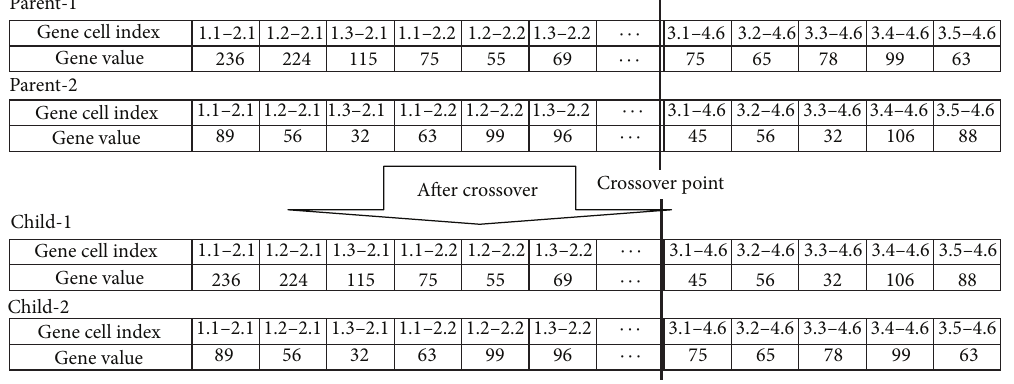
Figure 5: Crossover process.